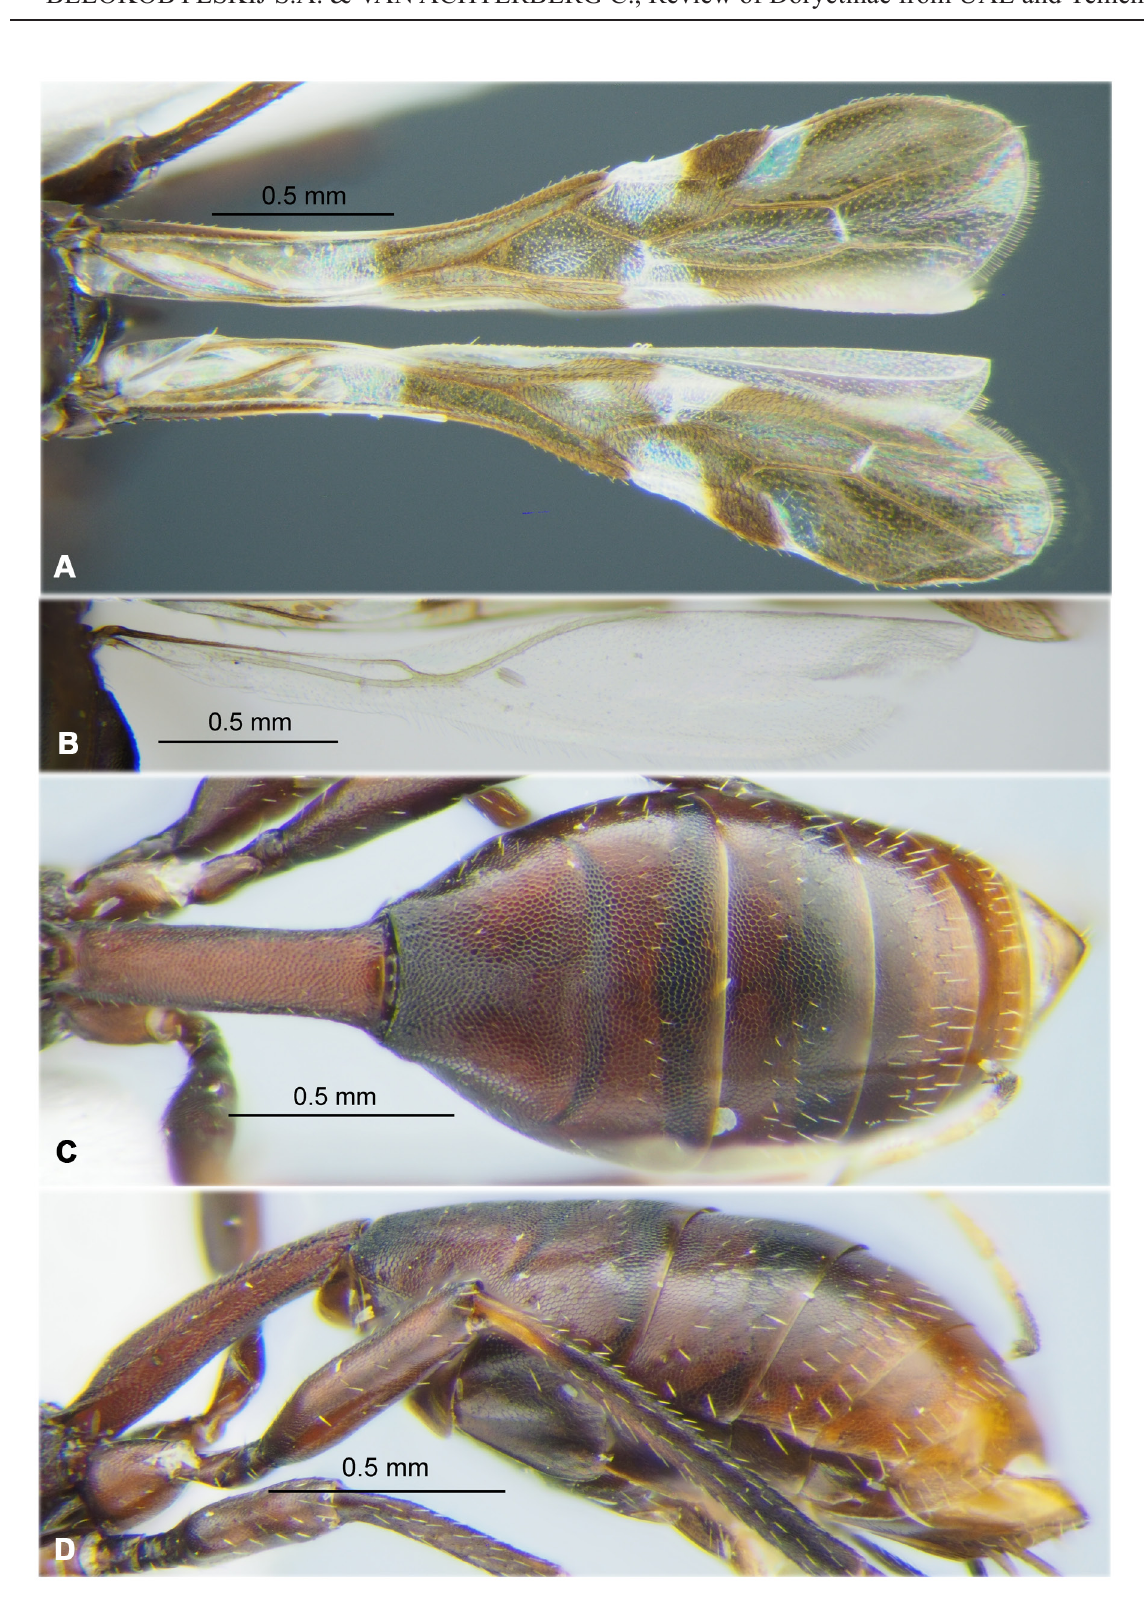
Fig. 15. Parana arabica Belokobylskij sp. nov., holotype, ♀ (RMNH). A . Fore wings. B . Hind wing. C . Metasoma, dorsal view. D . Metasoma, lateral